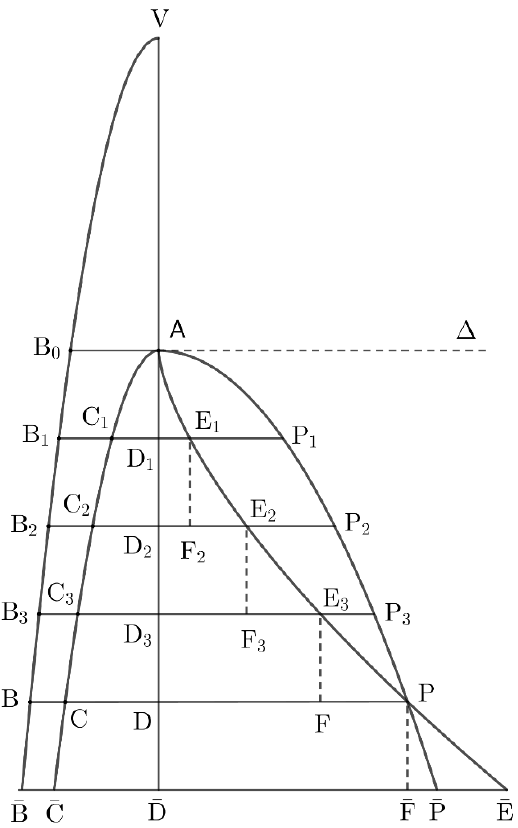
Figure 3. Wallis’ construction for the rectification of the parabola.